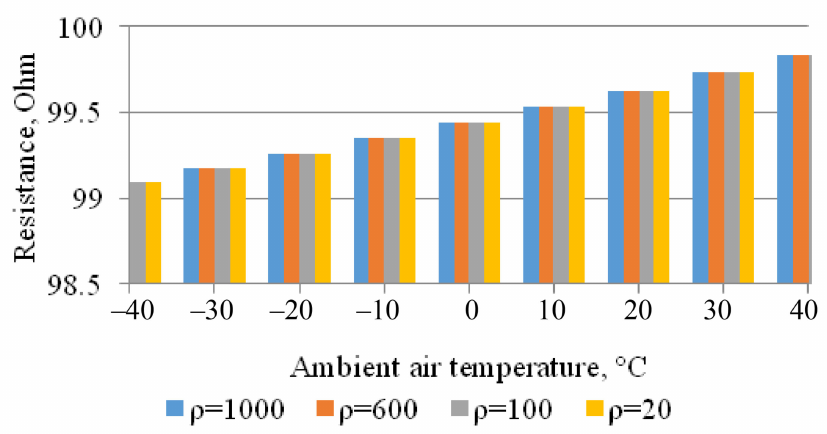
Figure 15. Changes in protection resistance setpoints during a three-phase short circuit for various soil resistance of overhead lines.